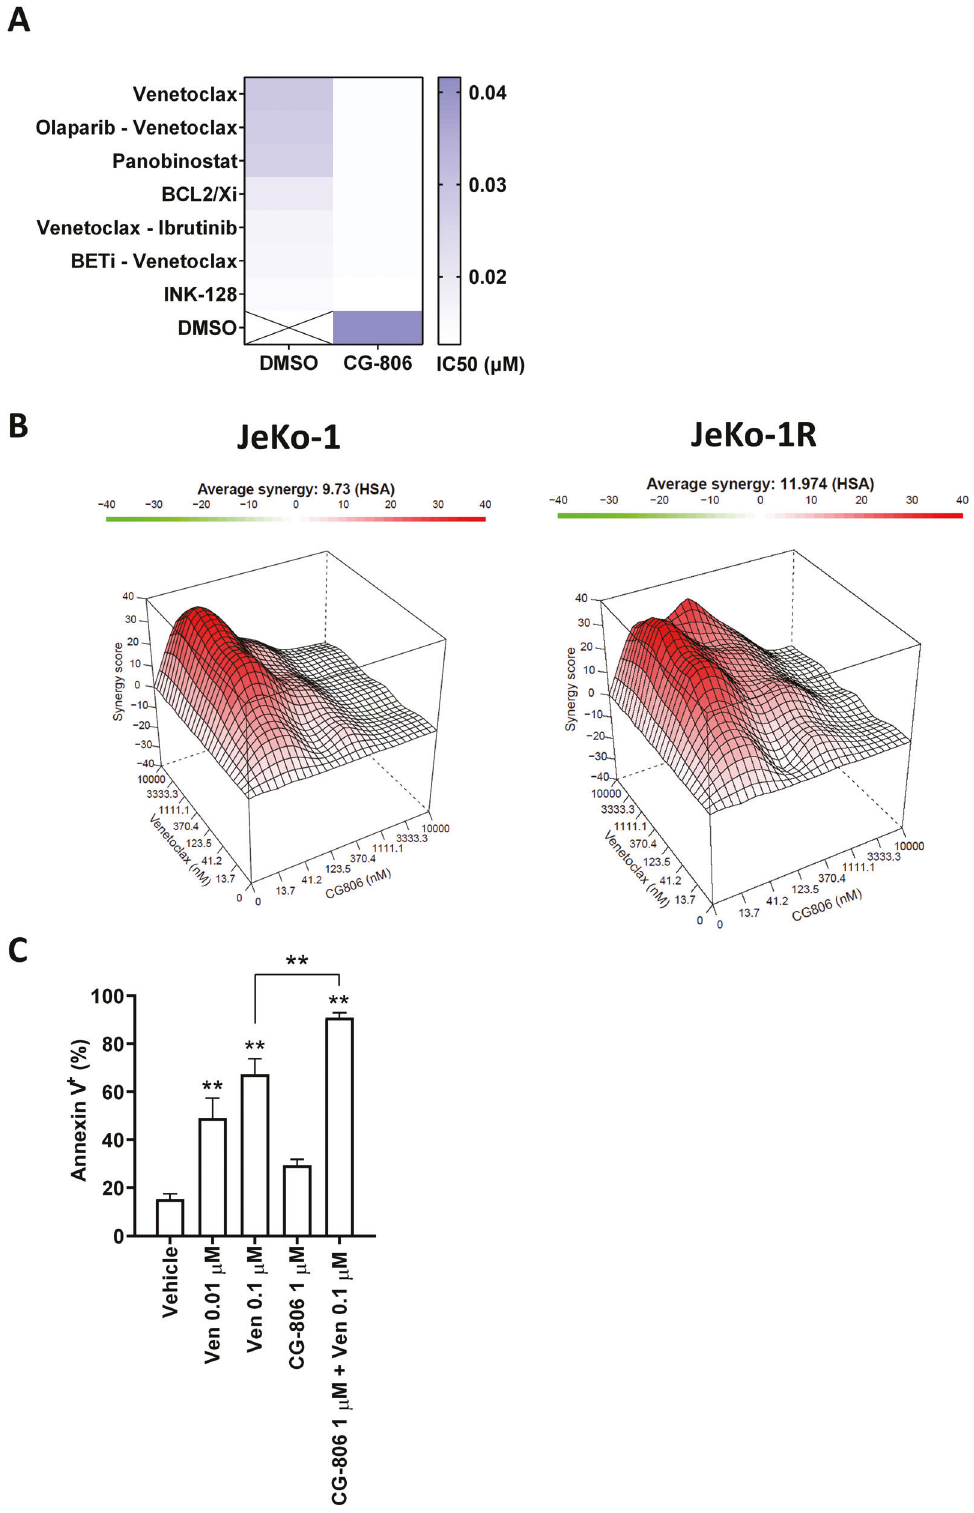
Fig. 6 Concurrent Bcl-2 inhibition sensitizes NHL cells to dual SYK/BTK inhibitor G-806. A U-2932 cells were subjected to functional screening assay as described in the methods. IC50 values were calculated (represented in the color gradient). Drugs that exhibit synergy with CG-806 are shown. B Visualization of calculated synergy map based on the dose-response matrix. JeKo-1 and JeKo-1R cells were treated with CG-806, venetoclax, or a combination of the two in an 7 × 7 matrix as indicated for 48 h. Cell proliferation was measured using a colorimetric tetrazolium-based assay; % viable cells were normalized to DMSO-treated control. C Primary MCL cells ( N = 4 individual samples analyzed in technical duplicates) were co-cultured with HS-5 stroma for 24 h. Cells were then treated with drugs for 24 h. Apoptosis of the CD19 + B-cell population was quanti fi ed using Annexin-V staining. * p < 0.05 and ** p < 0.01 vs. vehicle control.